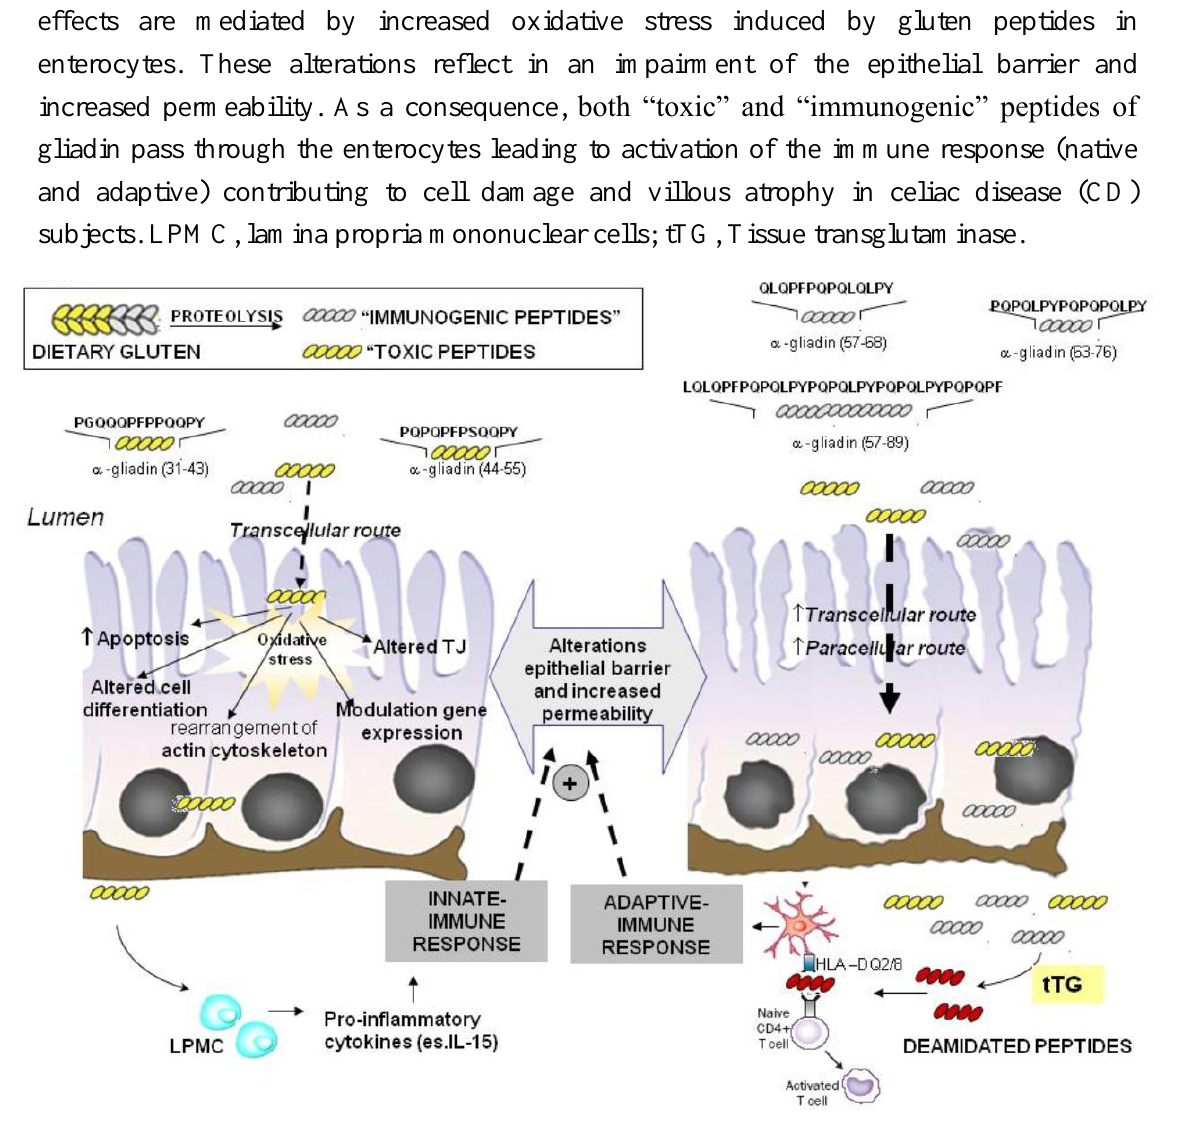
Figure 1. Intestinal epithelial damage in celiac disease: role of ―toxic‖ and ―immunogenic‖ peptides. ―Toxic‖ peptides in intestinal cells induce tight junction (TJ) dysfunctions